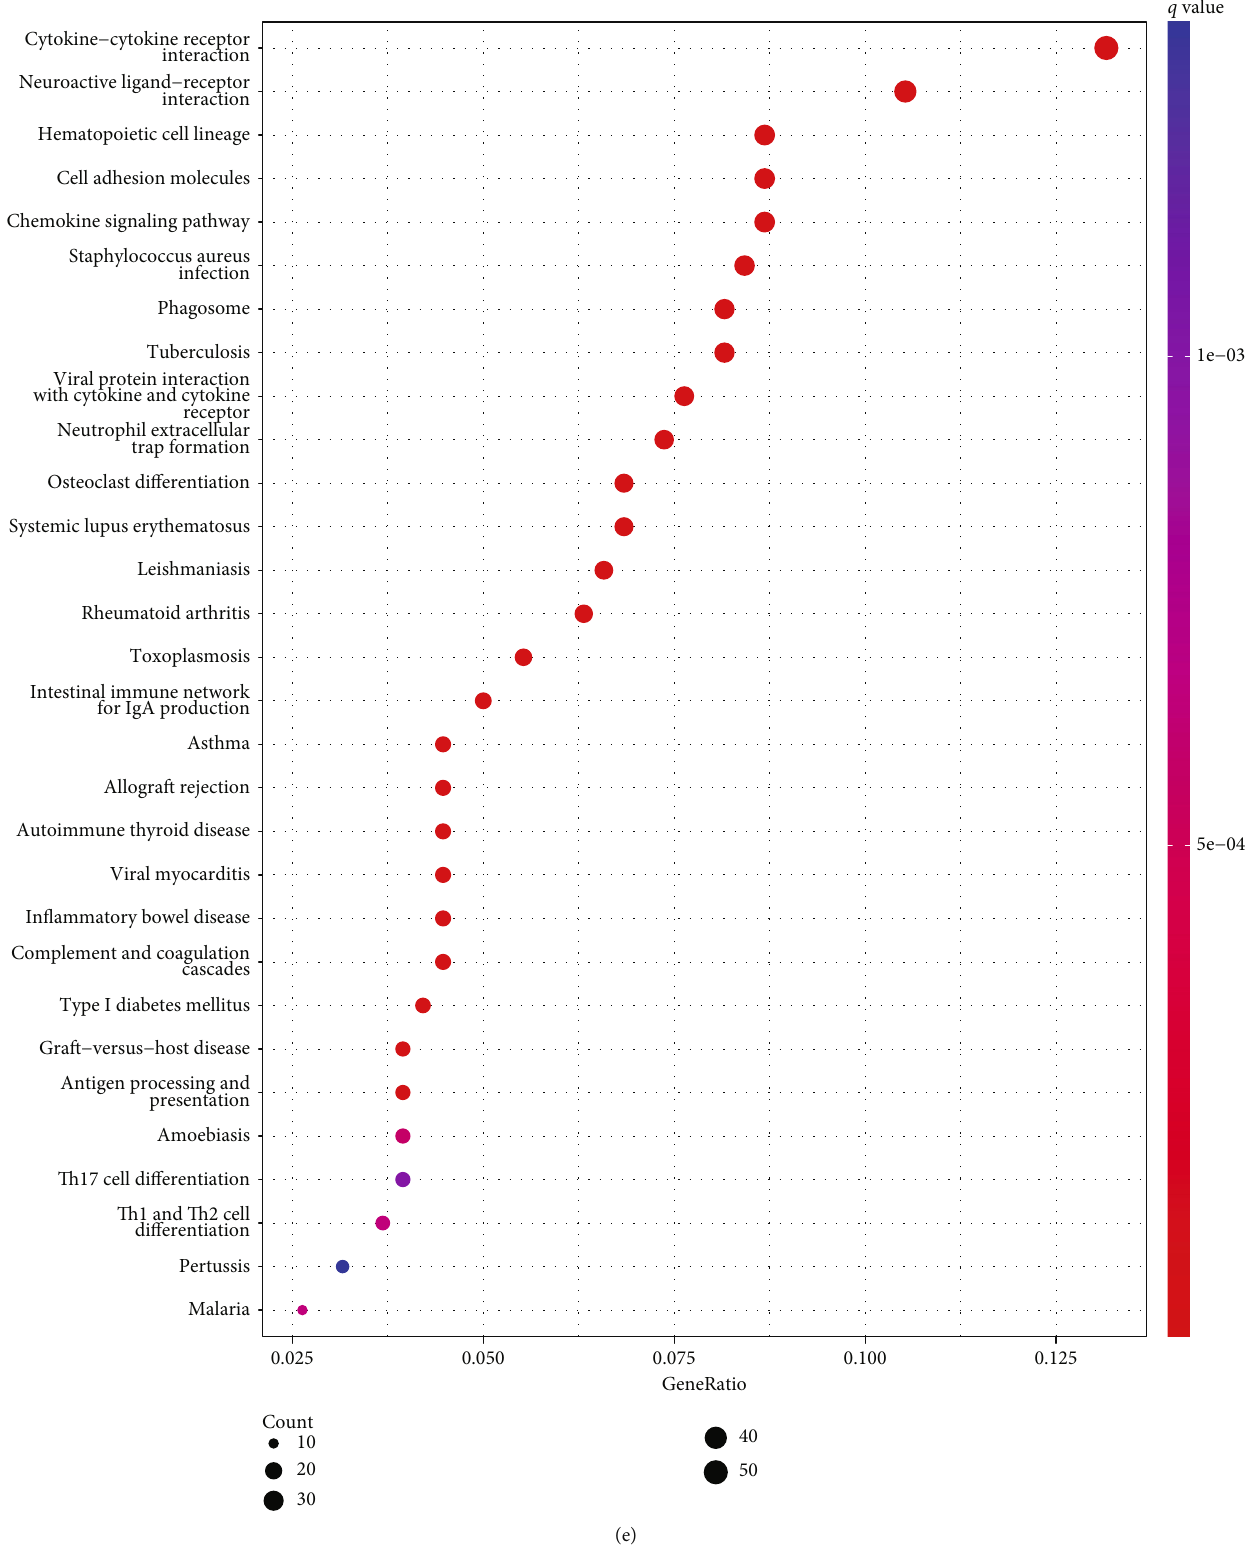
Figure 5: GO and KEGG pathway enrichment analyses for PTPRO-related genes. (a) Heatmap of di ff erential genes (DEGs) with high and low PTPRO expression level in LUAD patients. (b, c) Top 10 results of the GO enrichment analysis based on PTPRO-related DEGs. (d, e) The plots of the KEGG pathway enrichment analysis for PTPRO-related